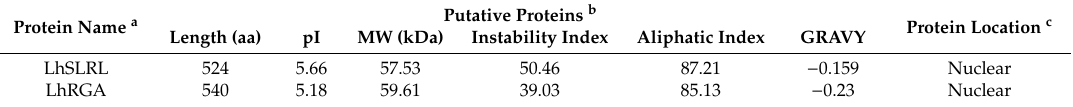
Table 1. List of putative DELLA gene family members of Liriodendron hybrids.